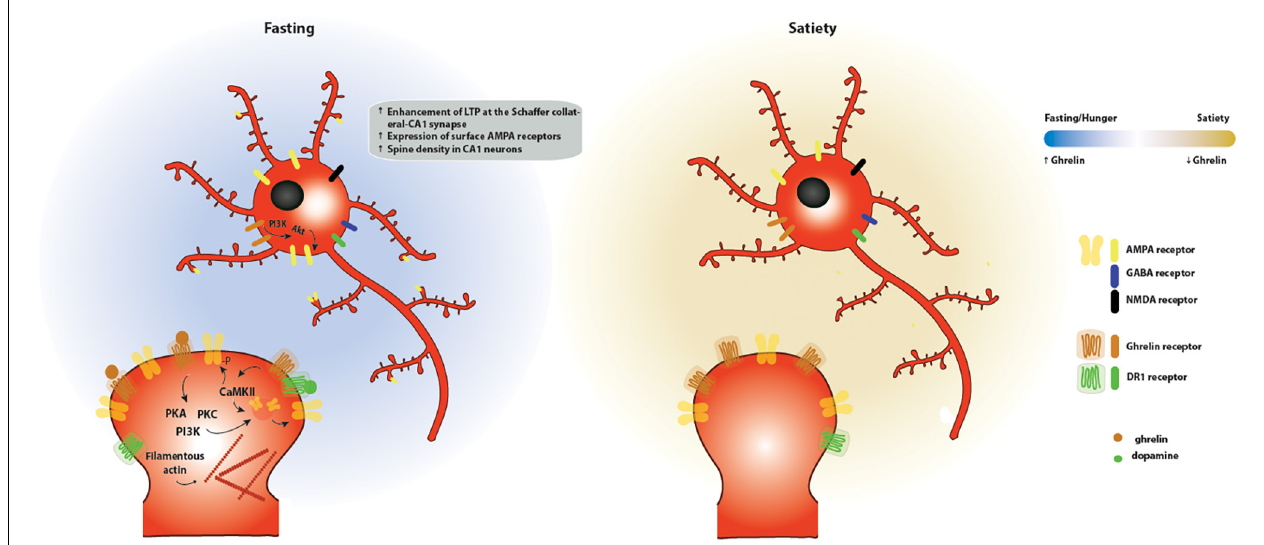
FIGURE 4 | Effects of ghrelin on synaptic plasticity in the hippocampus. Two energy states are represented: fasting/hunger and satiety. During fasting or hunger, ghrelin increases the expression of LTP at the Schaffer collateral-CA1 synapse promoting the insertion of AMPA receptors through a mechanism dependent on PI3K, PKA and PKC activation. These functional changes are accompanied by an increase in the density of dendritic spines, as a result of an increase in the levels of filamentous actin. One potential mechanism for the effects of ghrelin on hippocampal plasticity is through activation of GSH-R1a-DR1R heteromers by dopamine, which promotes an increase in the phosphorylation of CaMKII and of AMPA receptor subunits at serine residues relevant for plasticity, leading to the synaptic incorporation of AMPA receptors in a GHS-R1a-dependent